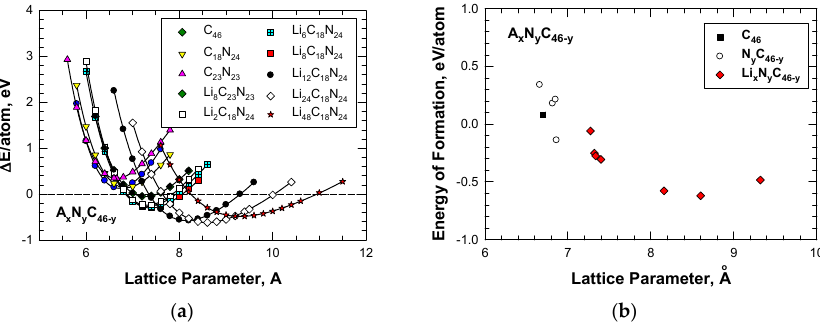
Figure 6. Cage structure of Type I nitrogen–carbon clathrate, N y C 46-y , with and without guest atoms: ( a ) empty N y C 46-y and ( b ) A x N y C 46-y with x number of guest atoms A residing within the cage. From Chan et al. [20].